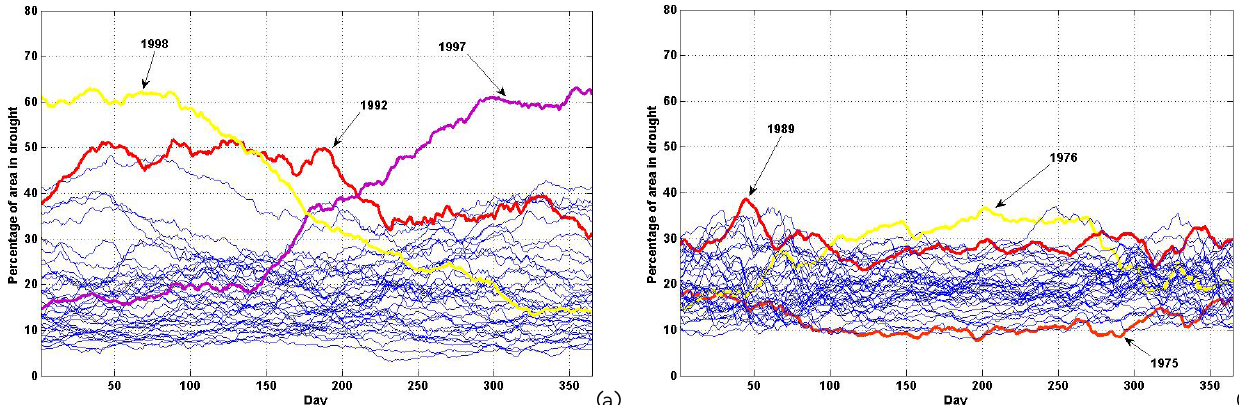
Fig. 9. Daily time series of percentage of area in drought for each year in the period 1963 to 2001 in Af and Cfb climates. (a) Areas with tropical rainforest climate (Af) and (b) Areas with maritime, temperate climate